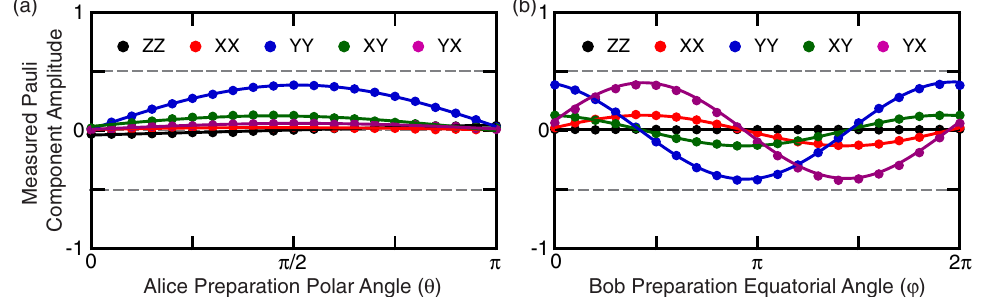
ffiffiffi p 2 Þðj g i þ j e iÞ , Bob was